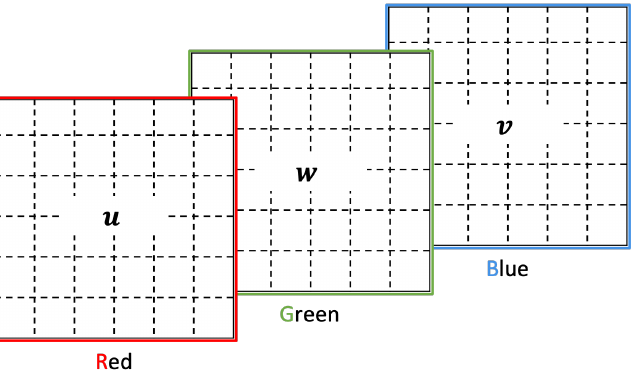
Figure 7. Simple color channel assignment to represent nearby time windows patterns. The second option we propose to represent neighboring time windows patterns is aimed at representing in a different manner the window w − 1 , which is right before the current window than the window w − 2 , which precedes w − 1 , and similarly for the windows after the current one. Specifically, for this case all channels use the same canvas with the same ‘marked’ and ‘unmarked’ pixels, obtained as we explained previously. However, the specific pixel value of each of the ‘marked’ and ‘unmarked’ pixels is based on the previous windows (i.e., w − 1 and w − 2 ) for the red channel, on the current window w 0 for the green channel, and on the following windows (i.e., w + 1 and w + 2 ) for the blue channel. The purpose of this is to encode in the color of the image as much information as possible of what can be found in the neighbor time windows of the current one. The red channel’s ‘marked’ pixels are derived from considering the value of the pattern p − 2 corresponding to the same area for the image representing one window before the previous (i.e., w − 2 ) scaled within the range of color values [ 0, 255 ] . This is p (cid:48) − . After that, the 2 pixel value is obtained by adding p (cid:48) − to the minimum possible pixel value (i.e., 0) as 2 . The process for the red channel’s ‘unmarked’ pixels, on the other hand, R ‘marked’ = 0 + p (cid:48) − 2 considers the pattern corresponding to the immediate previous window (i.e., p − 1 ), which is scaled within the range of possible pixel values [ 0, 255 ] to obtain p (cid:48) . Then, the pixel − 1 value is obtained by subtracting p (cid:48) from the maximum possible pixel value (i.e., 255) as − 1 . The pixel value for the green channel is obtained considering the R ‘unmarked’ = 255 − p (cid:48) − 1 scaled pattern value of the current window p (cid:48) as G ‘marked’ = 0 + p (cid:48) for ‘marked’ pixels 0 0 and G ‘unmarked’ = 255 − p (cid:48) for ‘unmarked’ pixels. Finally, the pixel values for the blue 0 channel’s ‘marked’ and ‘unmarked’ pixels are obtained as B ‘unmarked’ = 255 − p (cid:48) and + 1 , respectively. This process is illustrated in Figure 8, focusing only on B ‘marked’ = 0 + p (cid:48) + 2 one specific region in the middle of a particular quadrant within an image representation. As it can be observed, all the channels in the color image at the bottom of the figure share the same ‘marked’ and ‘unmarked’ pixels, which follows the configuration found in the image representing w 0 . The difference is only on the pixel value that each of the ‘marked’ and ‘unmarked’ pixels will have on each of the